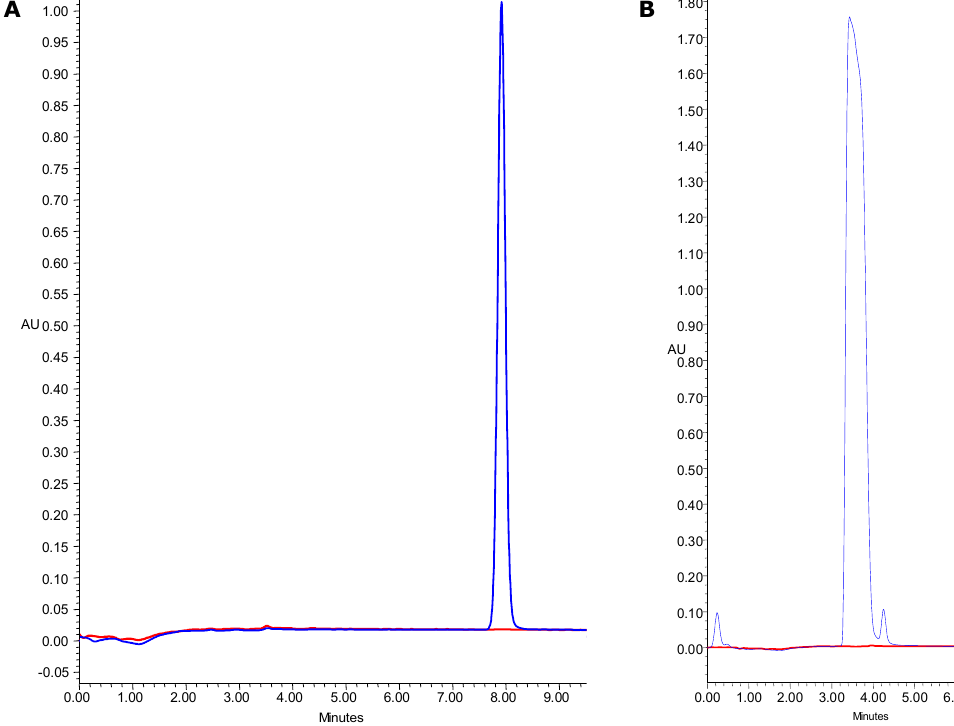
Figure 2. Chromatographic profile HPLC-PDA obtained before and after the derivatization using the ABTS · + reagent for: hydroxymethylfurfural ( A ); and furosine ( B ). The measurement was performed three times for independent samples and there were no significant differences between the results. ( p > 0.05).